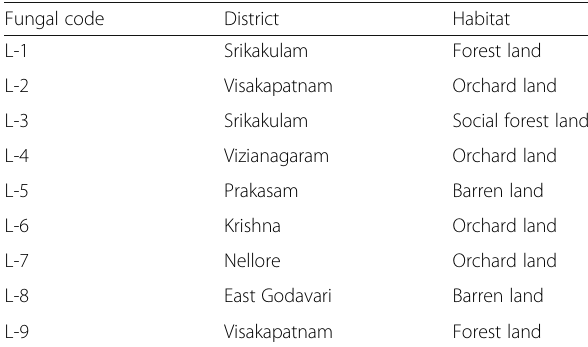
Table 1 Fungal codes, districts, and habitats of Coastal Andhra